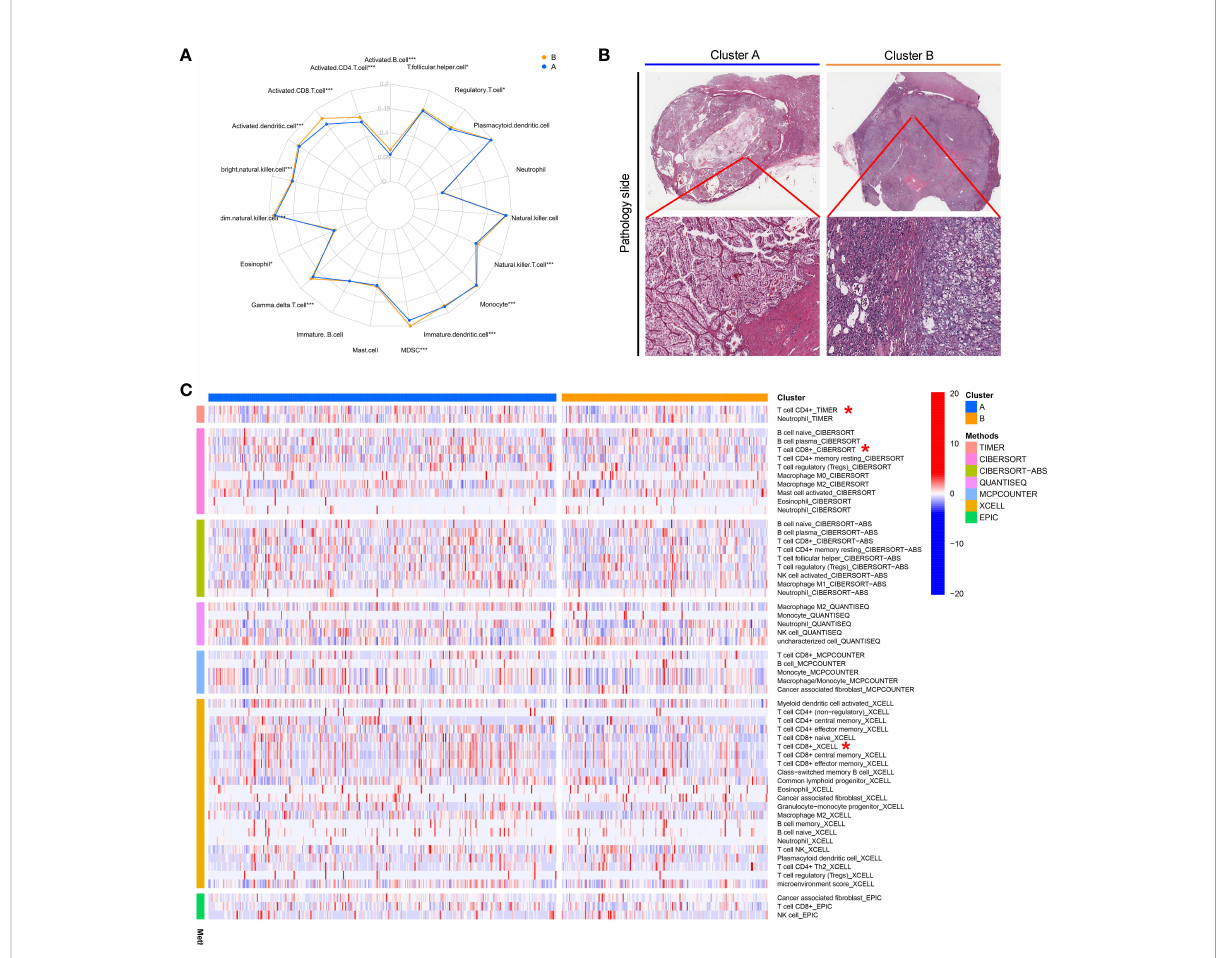
FIGURE 3 The immune landscape and biological characteristics of two cuproptosis phenotypes. (A) Radar chart of discrepancy immune in fi ltration of two phenotypes. (B) Representative images of the pathological HE staining of the two phenotypes from the TCGA dataset. (C) The enrichment levels of immune cells in two phenotypes. * P < 0.05, *** P <